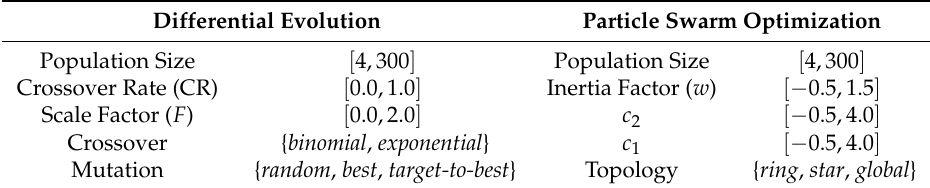
Table 1. Search ranges for the DE and PSO parameters. We chose ranges that are wider than those usually considered in the literature, to allow SEPaT and EMOPaT to “think outside the box”, and possibly find unusual parameter